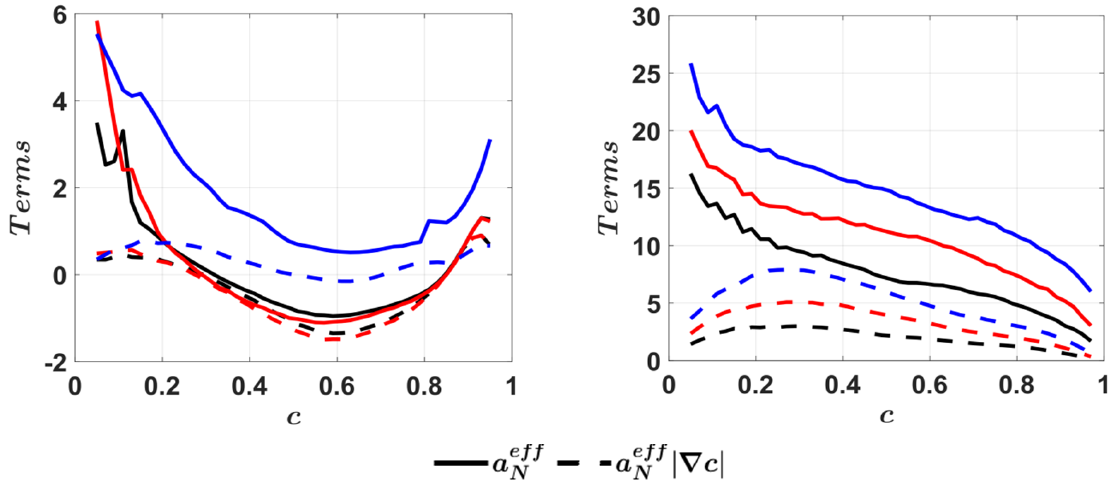
ef f × δ |∇ c | × δ 2 / S L th / S L ) and a N N th